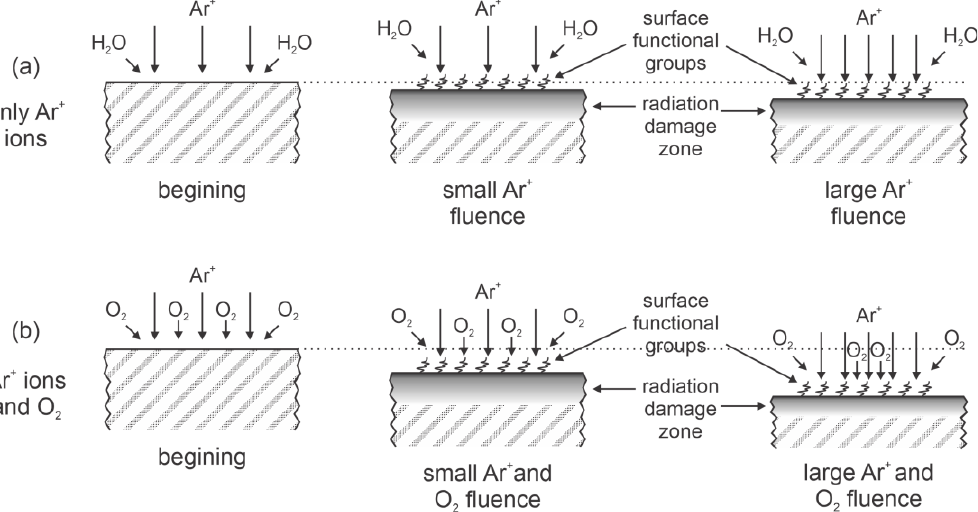
Figure 3. Illustration of the surface effects upon irradiation of PEEK with Ar + ions in the absence of oxygen ( a ) and oxygen presence ( b ) .